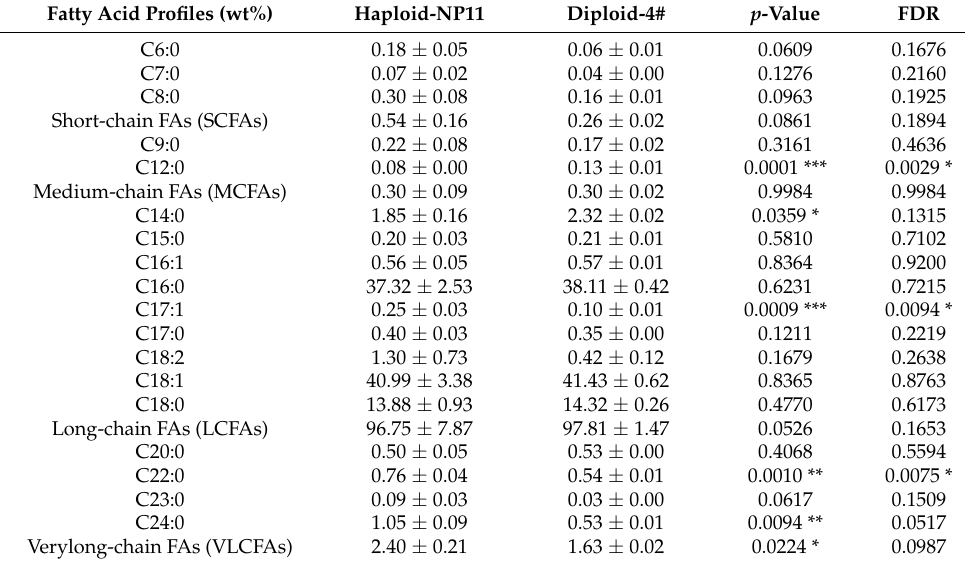
Table 1. Fatty acid compositional profiles of haploid strain R. toruloides NP11 and diploid strain 4#. Fatty Acid Profiles